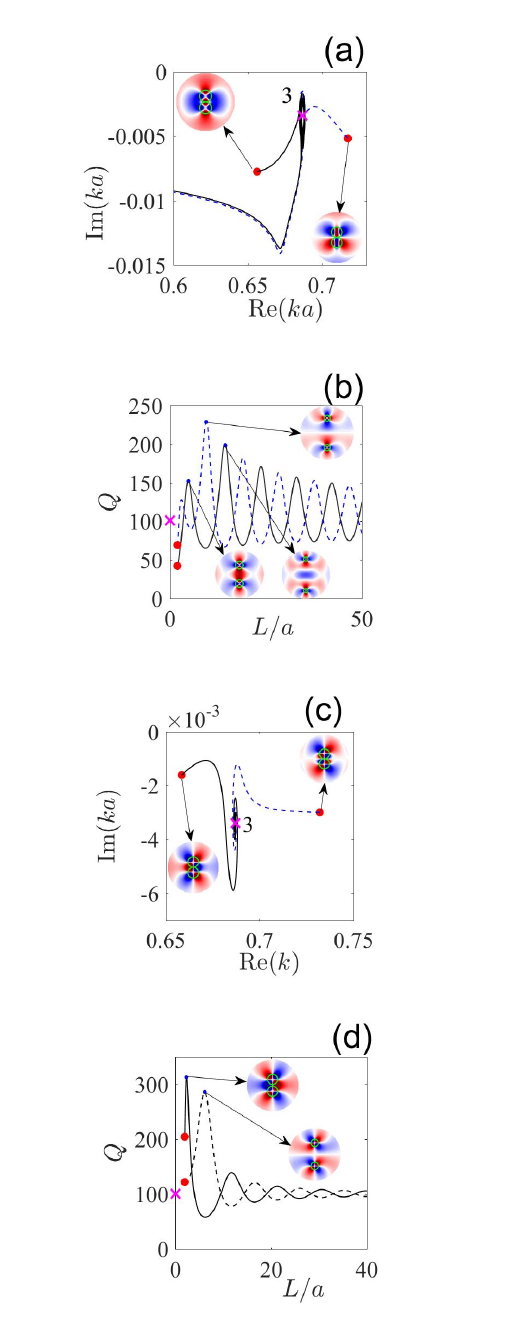
Figure 9: The evolution of quadruple resonant modes under vs the distance. Crosses mark the Mie resonances shown in Fig. 4. Red closed circle marks the case of the smallest dis- tance and open green circle marks the distance L = 1000 a